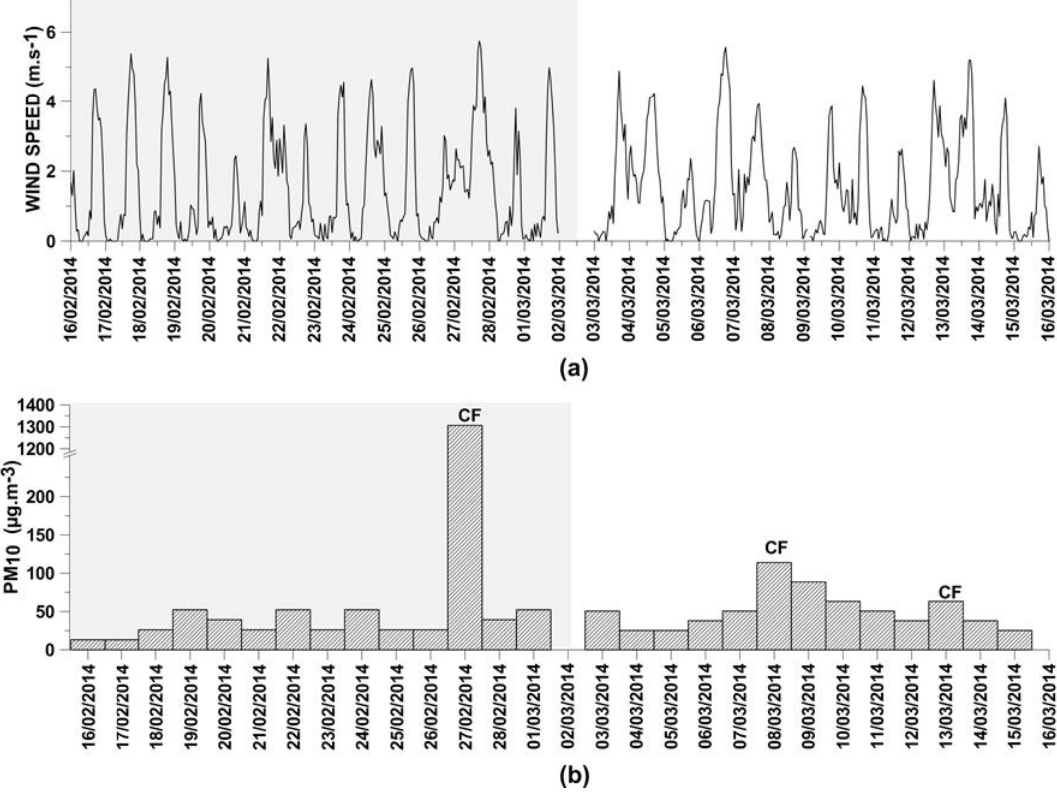
Figure 5. Mean hourly wind speeds calculated from 10 min measurements ( a ) and 24-h average PM 10 concentration ( b ) during the monitoring campaign. The shaded part refers to winds and concentrations downwind from Lajas Maciel while the clear part refers to winds and concentrations downwind from Plan de Ayala. The notation CF refers to the entrance of a cold front event, characterized by greater than normal winds. Discontinuity in plot represents the day for change of location of equipment.